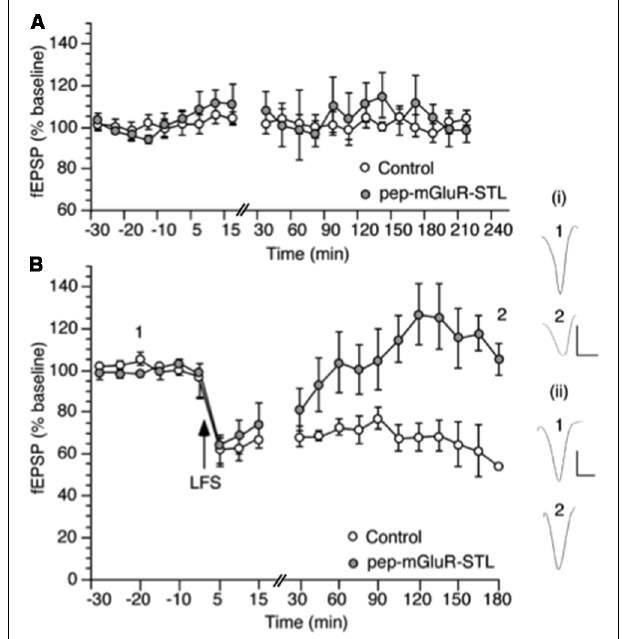
FIGURE 3 | Pep-mGluR-STL prevents persistent long-term depression (LTD) in the hippocampal CA1 region. (A) Basal synaptic transmission is not affected by the prior application of pep-mGluR-STL (25 µ g, n = 5) compared to responses evoked in hippocampal slices from animals that had been treated with control peptide ( n = 5). (B) Low frequency stimulation (LFS, 2 Hz, 1,200 pulses) induces persistent LTD which lasts for at least 3 h in the CA1 region of hippocampal slices from animals that were treated with control peptide ( n = 6). Treatment with pep-mGluR-STL (25 µ g, n = 6) significantly prevents the expression of LTD. Line-breaks indicate changes in time-scale. Analogs represent responses elicited in the presence of: (i) control peptide; and (ii) pep-mGluR-STL at the time-points noted. Vertical bar: 1 mV, Horizontal bar: 10